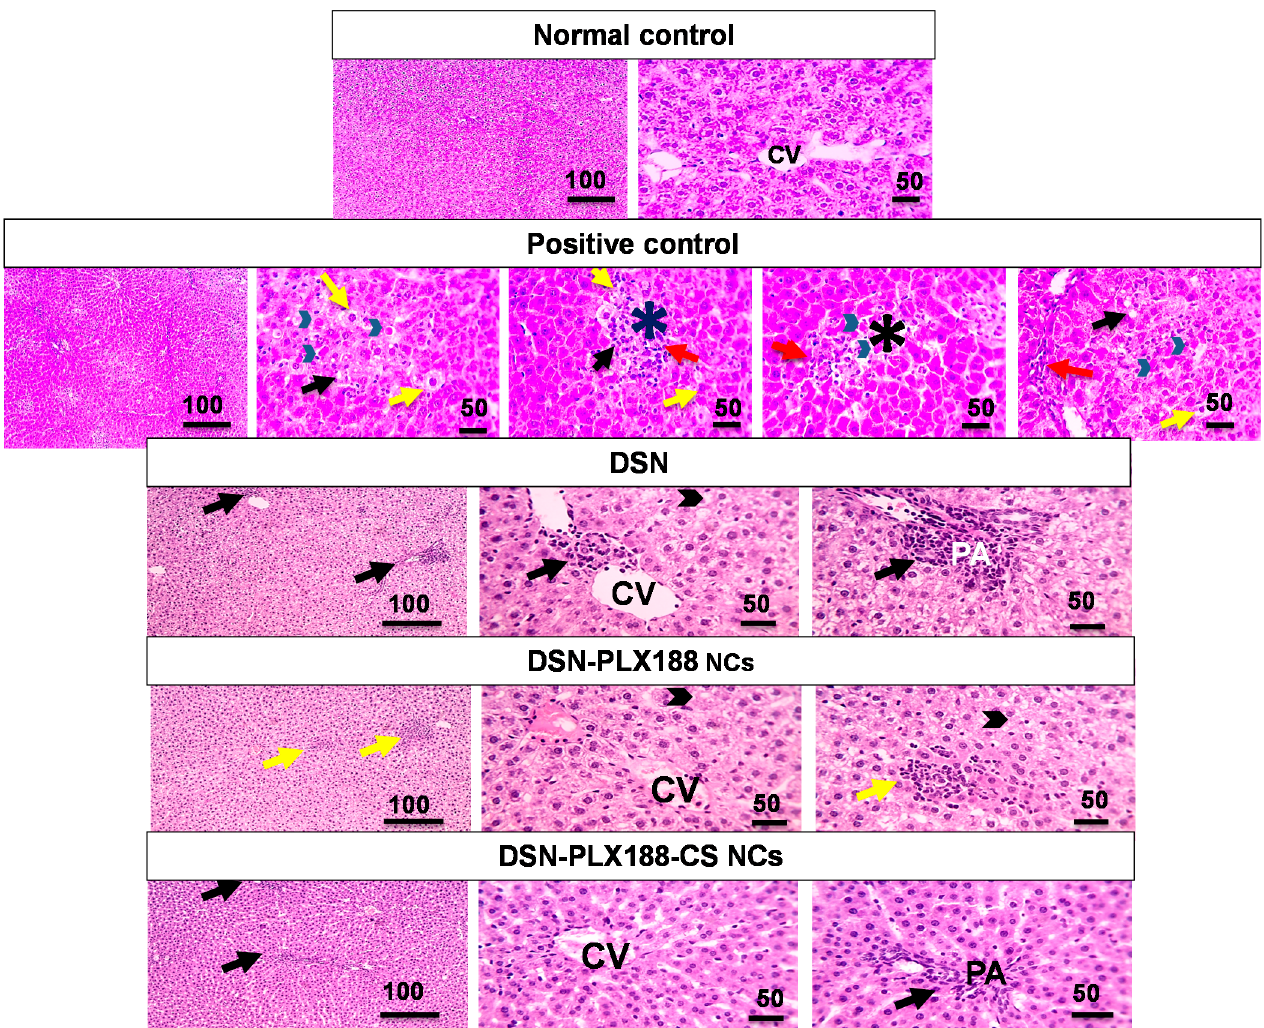
Figure 7. Microscopic pictures of hematoxylin and eosin (H&E)-stained hepatic sections of the different groups following the pretreatment regimen. Low magnification x: 100 bar 100 µ m and high magnification Xx: 400 bar 50 µ m. CV, central vein; PA, portal area. In the positive control: focal areas of necrosis (asterisks); apoptosis (arrowheads); vacuolization (black arrows); hydropic degeneration (yellow arrows); hepatocytes with infiltration of a few leukocytic cells (red arrows). In the DSN-pretreated group: leukocytic cell infiltration close to the central vein (black arrow); portal inflammation (black arrow); hydropic degeneration in hepatocytes (arrowheads). In the DSN–PLX188-NC-pretreated group: lobular inflammation (yellow arrows); hydropic degeneration (arrowheads). In the DSN–PLX188–CS-NC-pretreated group: leukocytic cell infiltration in portal area (black arrow).